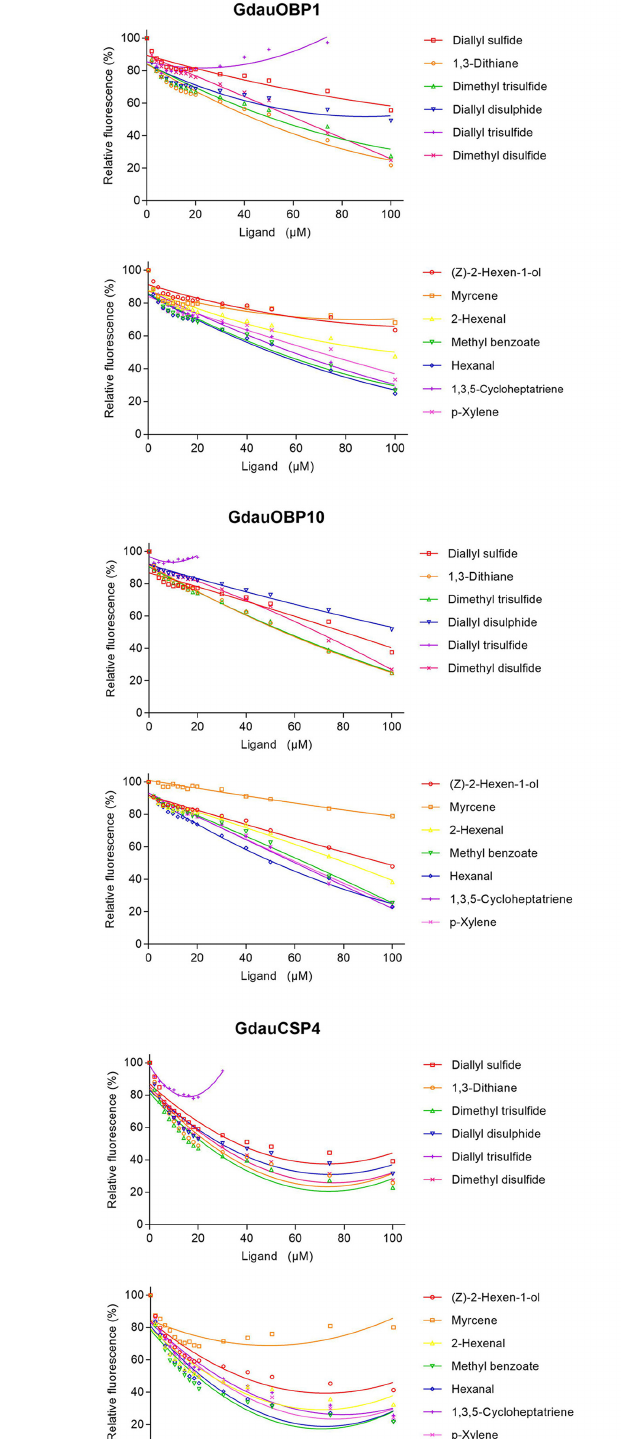
Frontiers in Physiology |